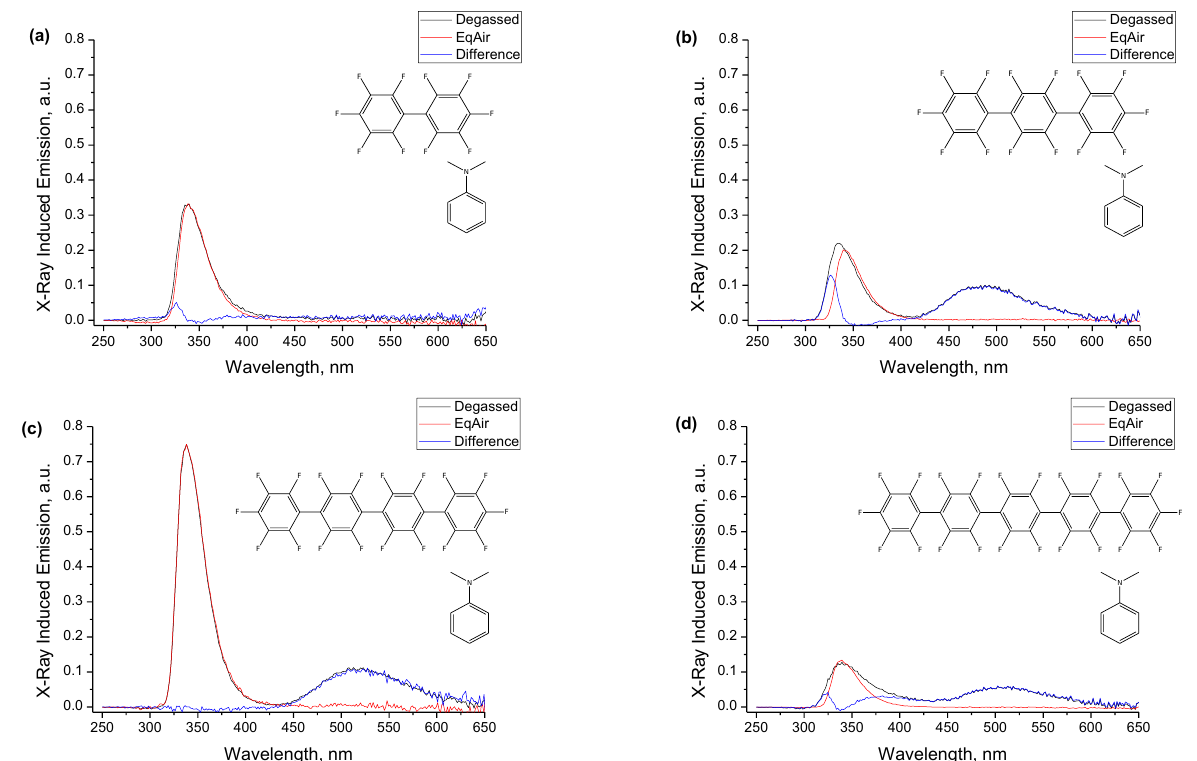
Figure 4. Spectra of X-ray-induced luminescence for the mixtures of the four compounds (( a )— 1 , ( b )— 2 , ( c )— 3 , ( d )— 4 ) with DMA in degassed and air-equilibrated n -dodecane solutions. Sample compositions are identical to those used in Figure 3. Each panel shows three spectra: from the degassed solution (black curve), from the same solution equilibrated with an ambient atmosphere (red curve, adjusted in magnitude to match the intensity of the short wavelength band of the local emission), and their difference (blue curve). A DMA concentration of 10 − 2 M in all samples, concentrations of compounds: 5 × 10 − 3 M for 1 , 1.8 × 10 − 3 M for 2 , 4.4 × 10 − 4 M for 3 , 1.1 × 10 − 4 M for 4